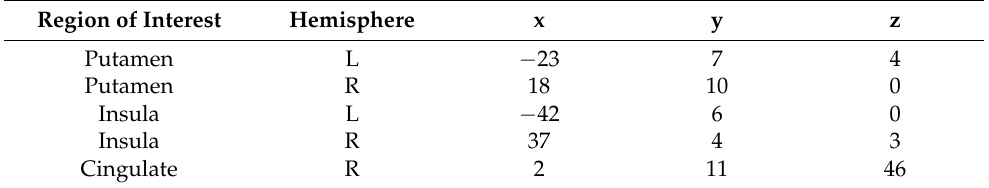
Table 2. Regions of interest used in this study. All coordinates are in MNI space. Region of